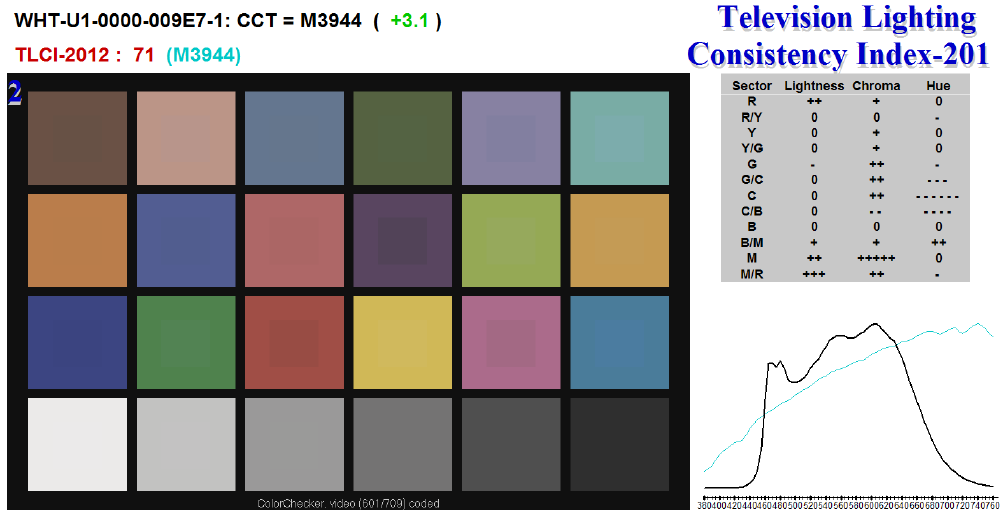
Figure 9. The Television Lighting Consistency Index (TLCI) performance of the chosen LED for 24 colour patches as the result of the TLCI application. The middle of each patch has a square of colour as evaluated for the tested LED while the remainder shows the reference